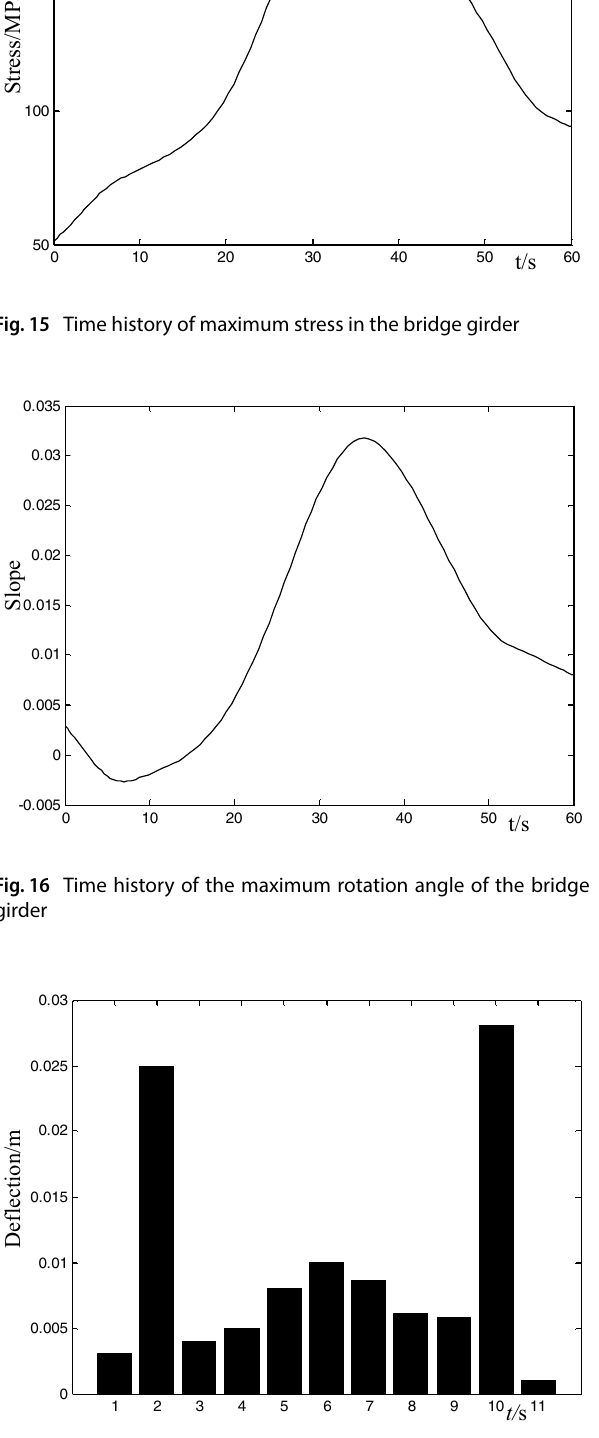
Fig. 17 Maximum deflection of each unit under moving train